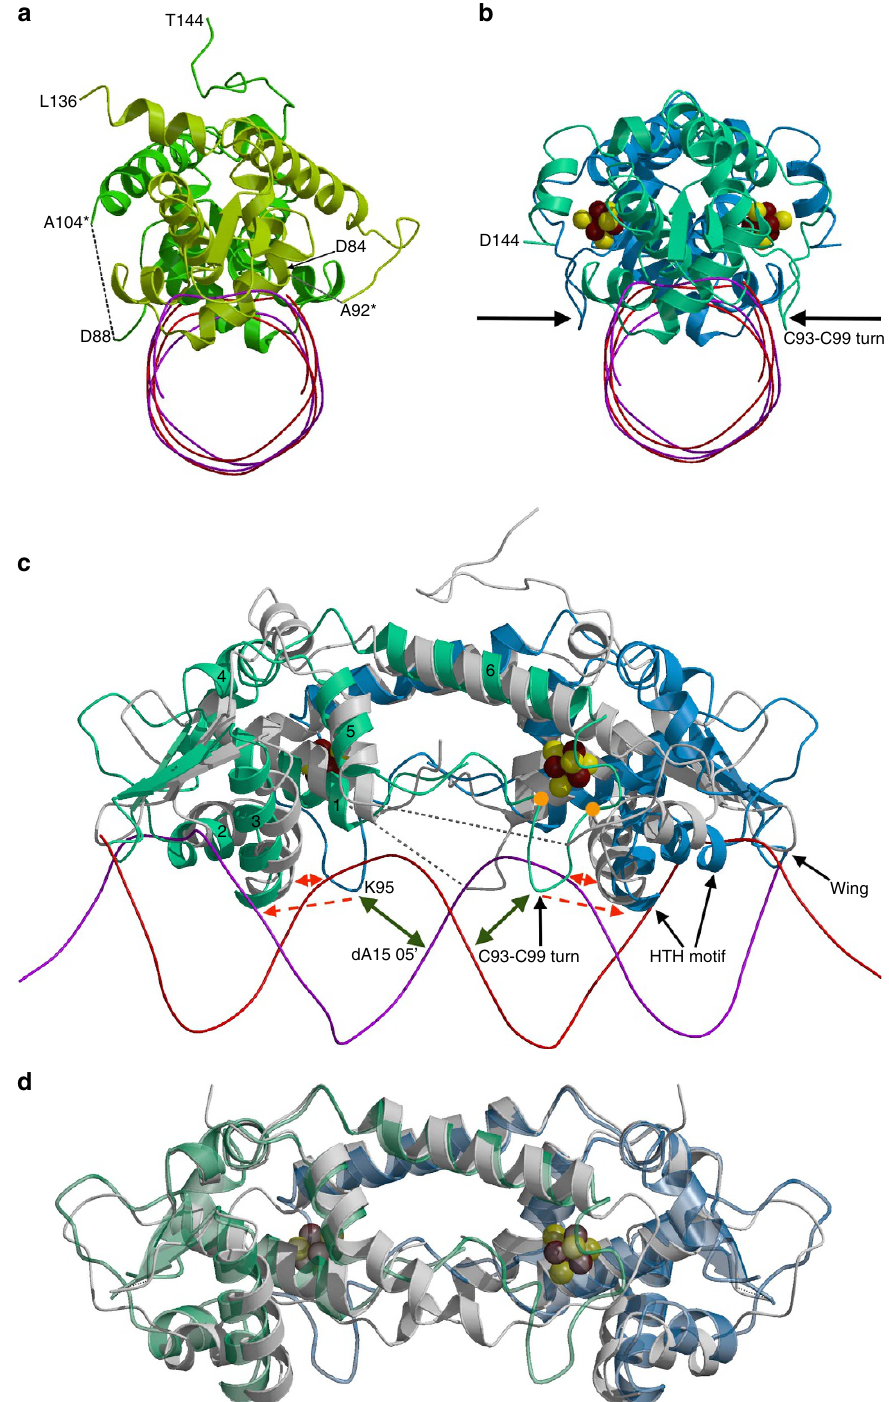
Figure 6 | Comparison of apo-IscR-DNA complex, holo- and apo-ScNsrR. Ribbon models of ( a ) the apo-IscR-DNA complex, ( b ) holo-ScNsrR superposed with the DNA part of apo-IscR-DNA, ( c ) a perpendicular view of the superposition and ( d ) superposition of holo- and apo 3CA-ScNsrR. In a A92* and A104* correspond to Cys residues in the native IscR protein. The black arrows in b point at the C 93 EGDNPC 99 turn in holo-ScNsrR. The corresponding region in IscR, shown as dotted lines between residues 84-92 and 88-104 in a , c , is disordered due to the absence of the [2Fe–2S] cluster. The DNA is represented by crimson and red lines. The apo-IscR fold is shown in grey in c , with holo-ScNsrR depicted as green and blue monomers. The red dashed arrows indicate how the C93–C99 turn displaces the a 3 RH region by about 2.5Å relative to its counterpart in IscR. The double-headed solid red arrow shows a potential clash between the putative C92–C98 turn and the RH as oriented in the apo-IscR structure. ScNsrR Cys93 and Cys99 C a ’s are depicted as yellow disks and [4Fe–4S] cluster atoms are shown as small red-brown and yellow spheres. The predicted interaction between Lys95 and the phosphate group of A15 in a holo-IscR-DNA complex is indicated by double-headed green arrows. HTH motif: helix-turn-helix DNA recognition motif; Wing: small groove recognition loop. See also Supplementary Fig. 5. In d 3CA-ScNsrR is depicted in grey and holo-ScNsrR in semi-transparent green and